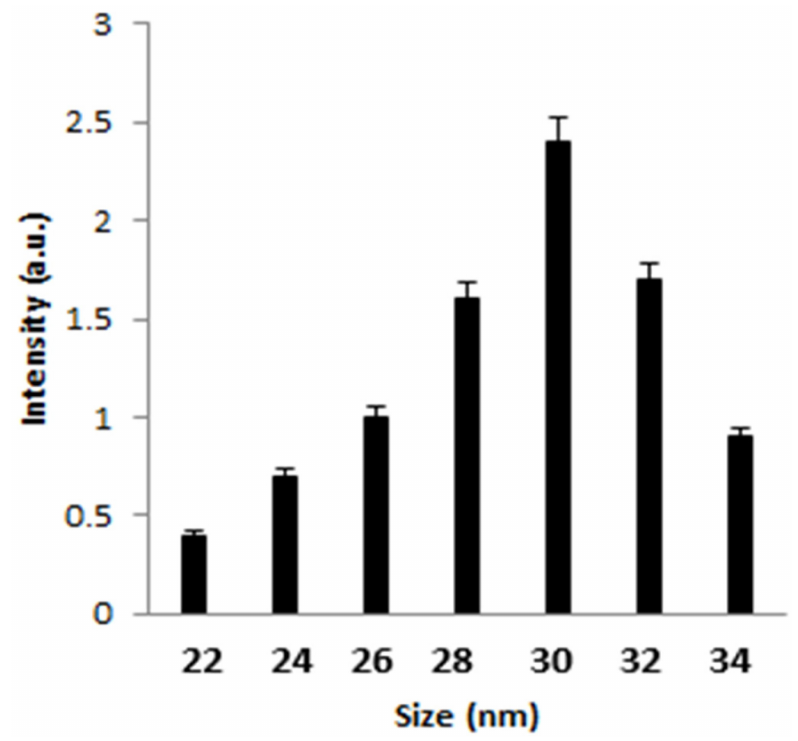
Figure 2. DLS of the synthesized AgNPS.